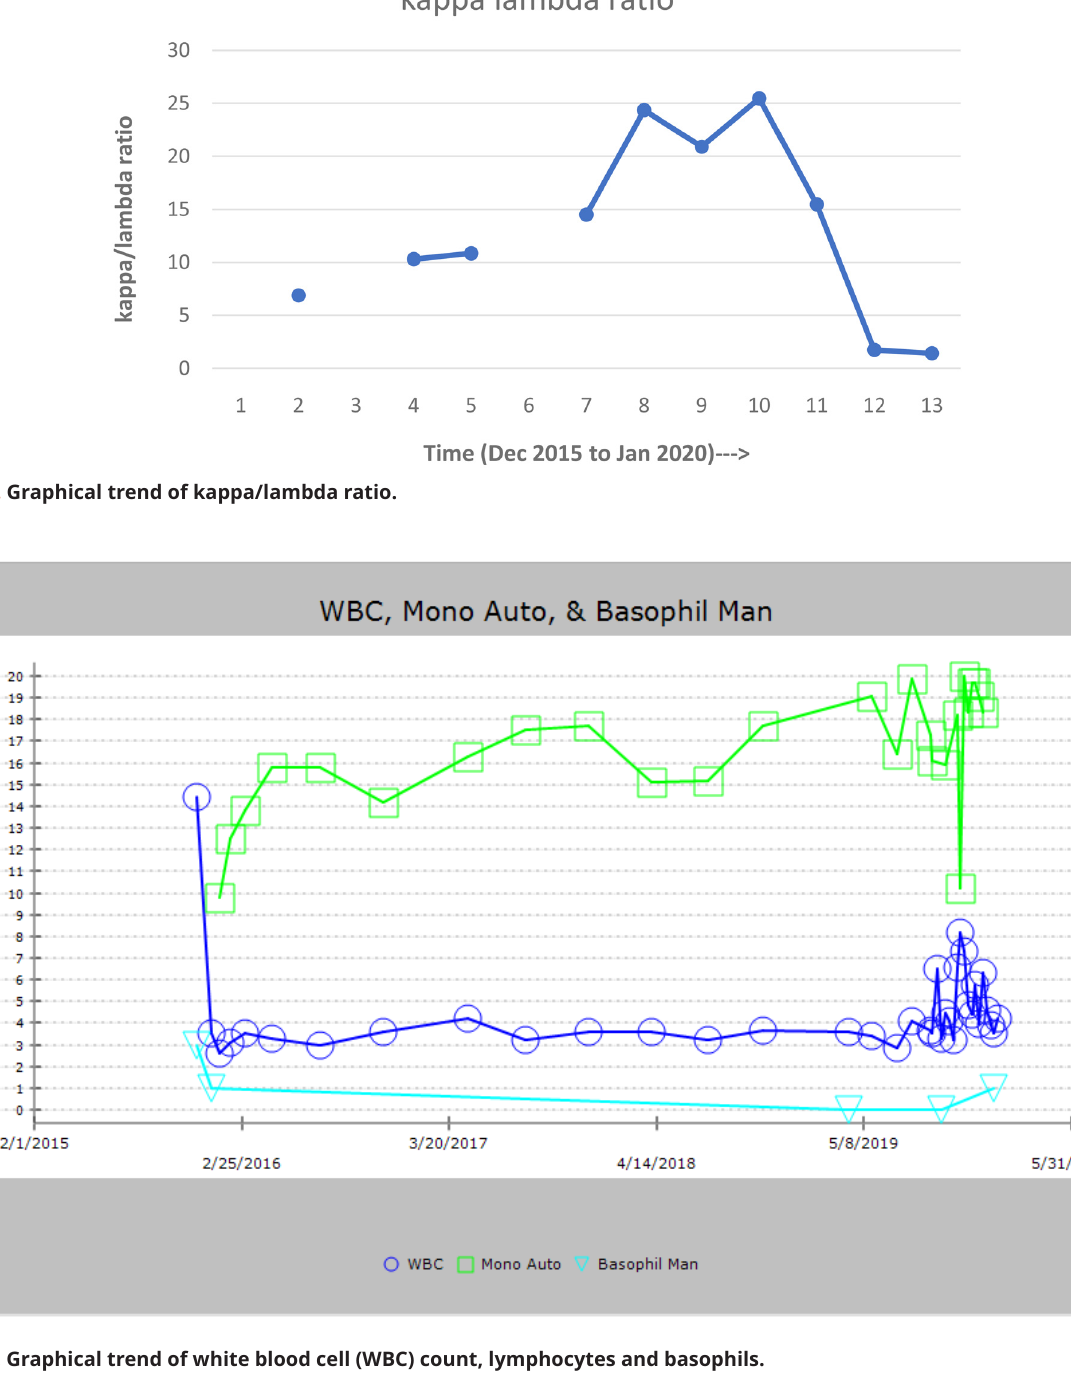
This regimen was preferred over the VRd (lenalidomide, bort- ezomib and dexamethasone) due to the concern for increased